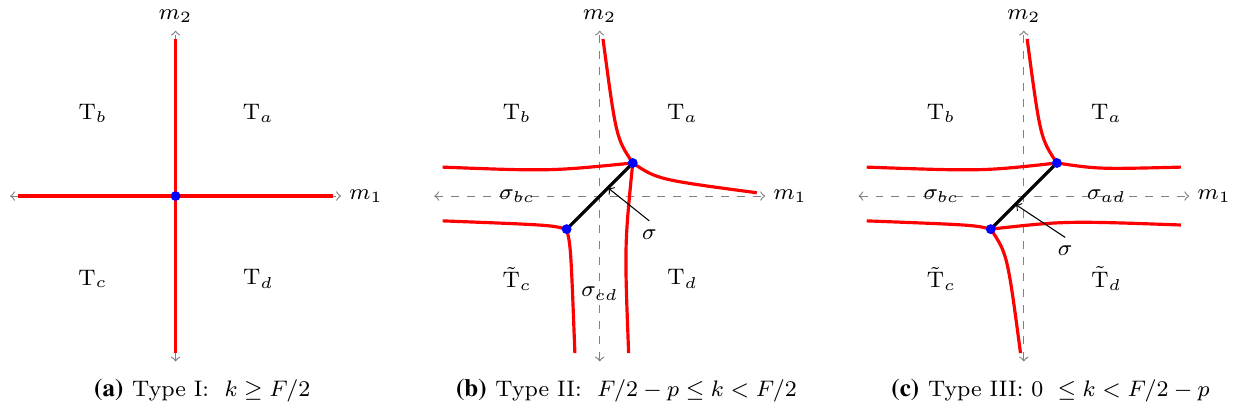
phase diagram to label this